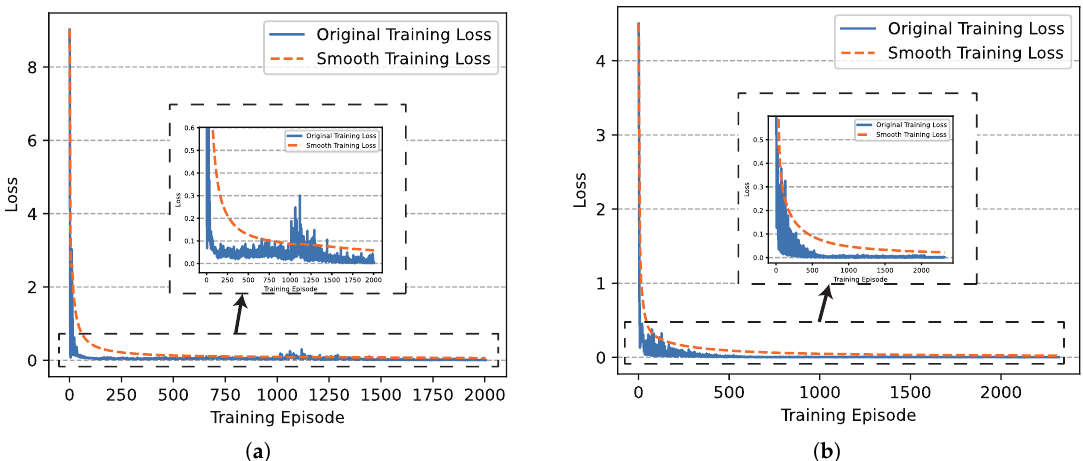
Figure 7. The comparison of critic networks’ training loss involved in Uniform Experience Replay (UER)-DDPG and PER-DDPG over training episode. ( a ) The training loss of critic network of UER-DDPG. ( b ) The training loss of critic network of PER-DDPG.